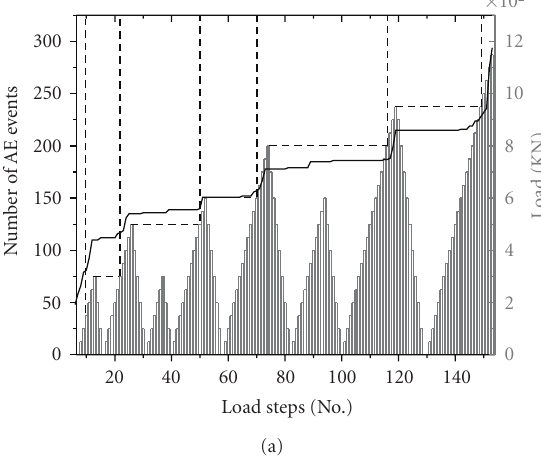
Figure 6: Surface wave velocity measurements during both the loading and unloading phases of load cycles 2 to 9. The arrows mark the average velocity di ff erence at the stress-free state before and after the application of load in each cycle. The second axis indicates the level of loading as a percentage of the final load at